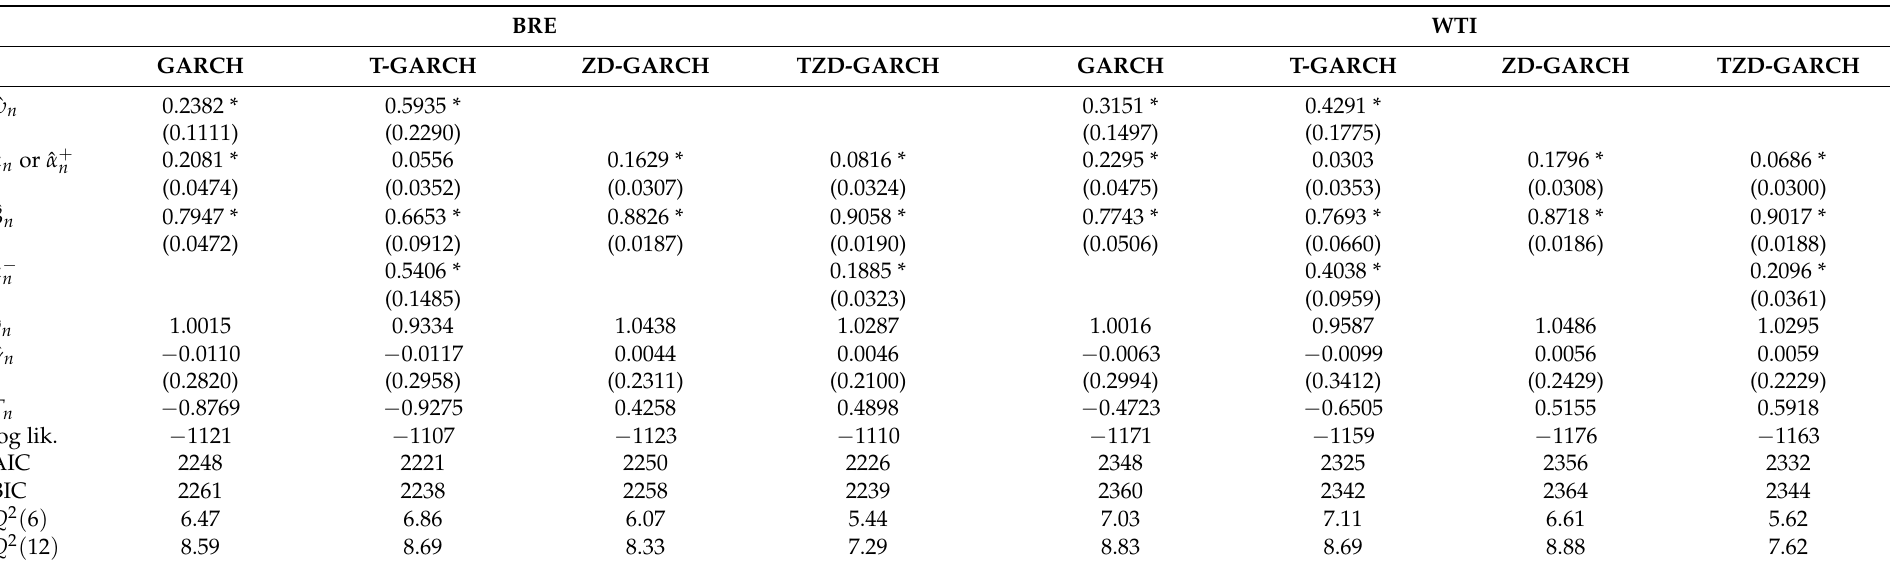
Table 3. Empirical results: BRE and WTI